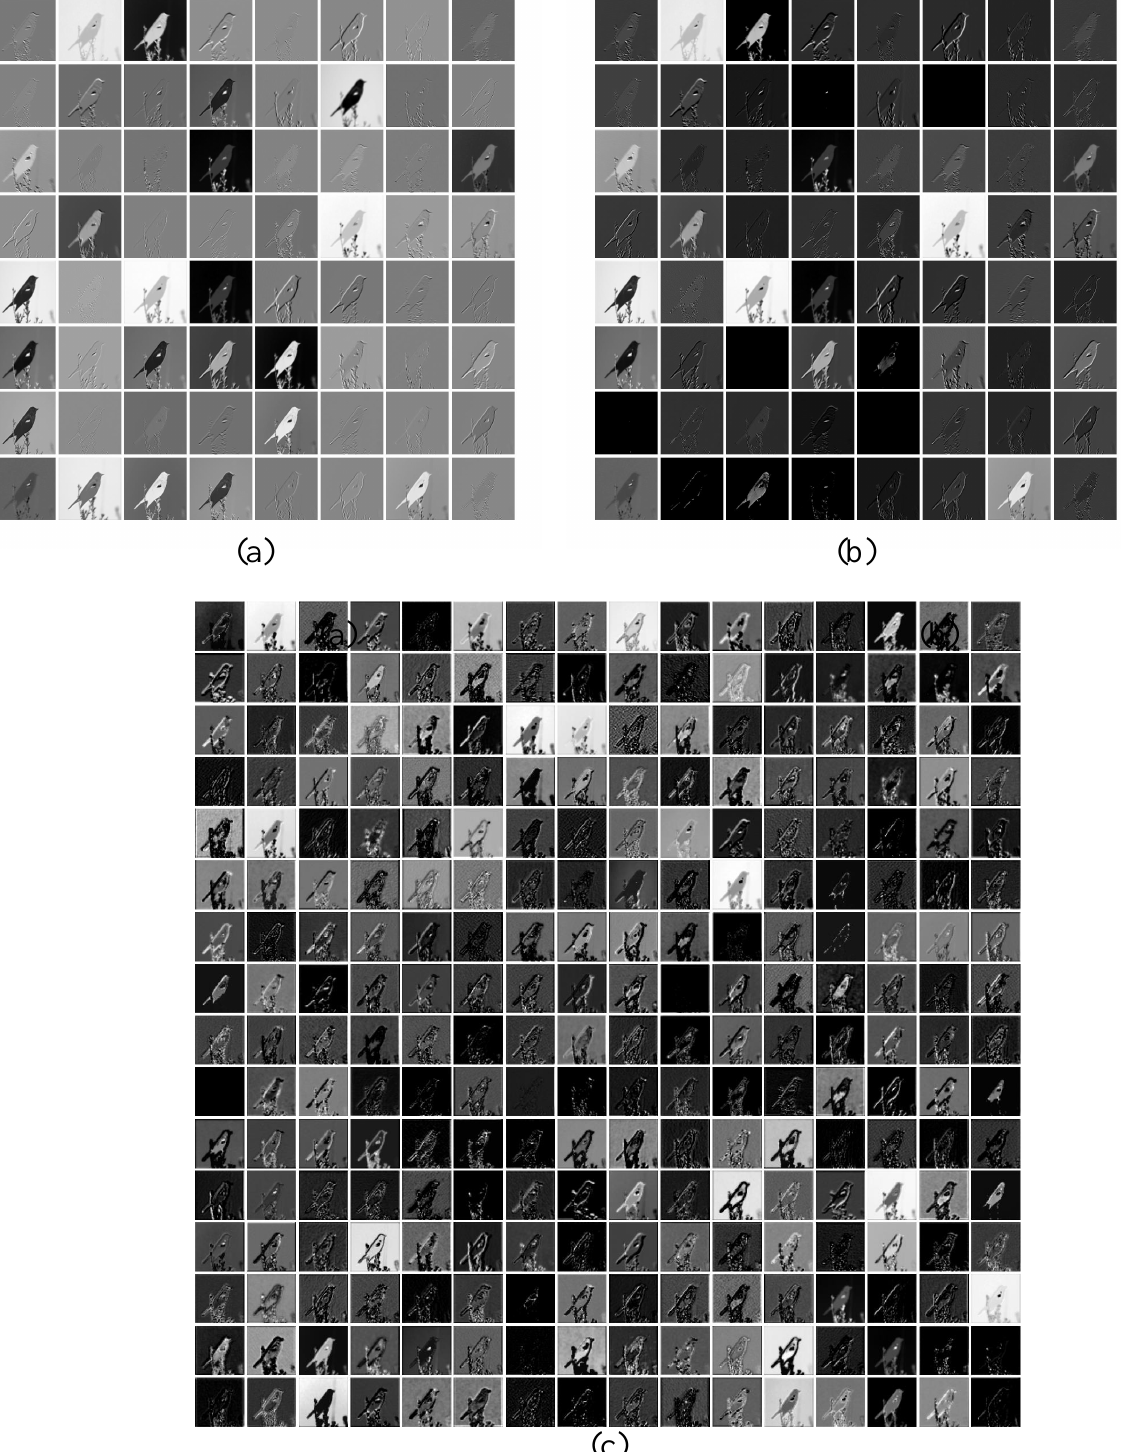
Figure 6. Visualization of iSQRT-COV based on the baseline ResNet50. ( a ) Visualization of the first layer of the network, ( b ) Visualization of the third layer of the network, ( c ) Visualization of the fifth layer of the